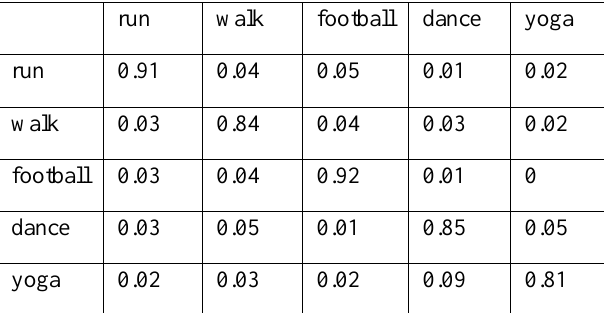
Table 1. Comparison of accuracy on MPII dataset